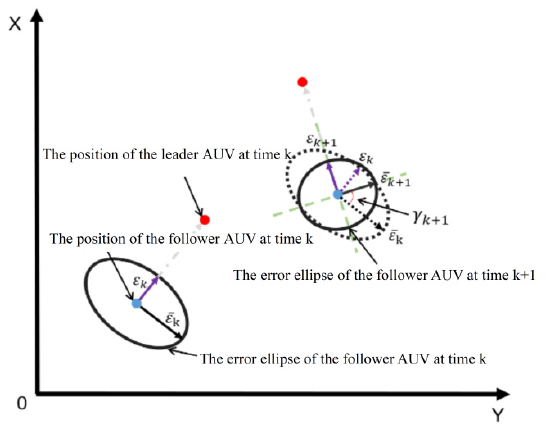
Figure 4. Multi-AUV cooperative positioning error model.